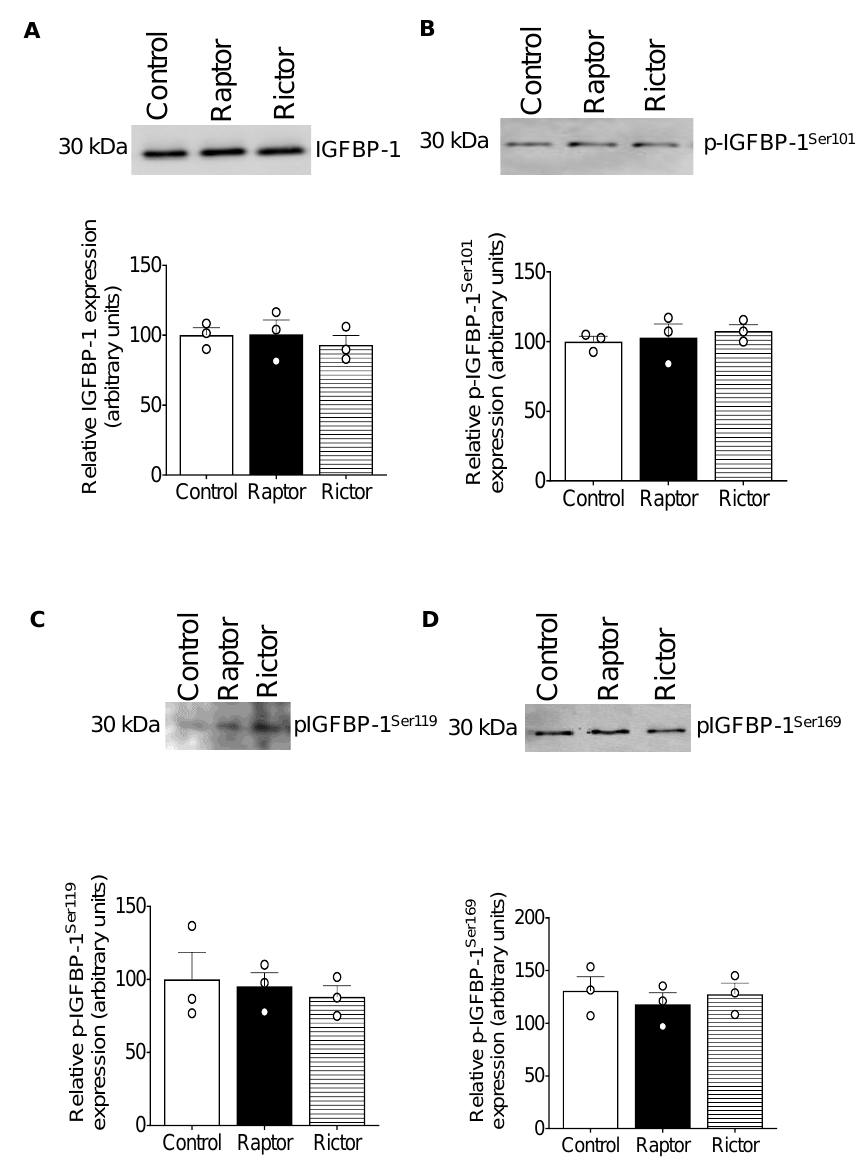
Figure 9. Analysis of IGFBP-1 secretion and phosphorylation from HepG2 cells after treatment by Renal Carcinoma cells transfected with the control, RAPTOR , and RICTOR siRNA. Equal aliquots of HepG2 cell media (7 µ L) were loaded on 1-D gels for a Western blot using anti-human IGFBP-1 monoclonal antibody (mAb 6303) ( A ); 40 µ L loaded for pSer101 ( B ), pSer119 ( C ), and pSer169 ( D ). Samples were normalized to the control. The data were represented as Mean + SEM in bar figures and analyzed with a one-way ANOVA and Bonferroni Multiple Comparison tests; p < 0.05 was considered